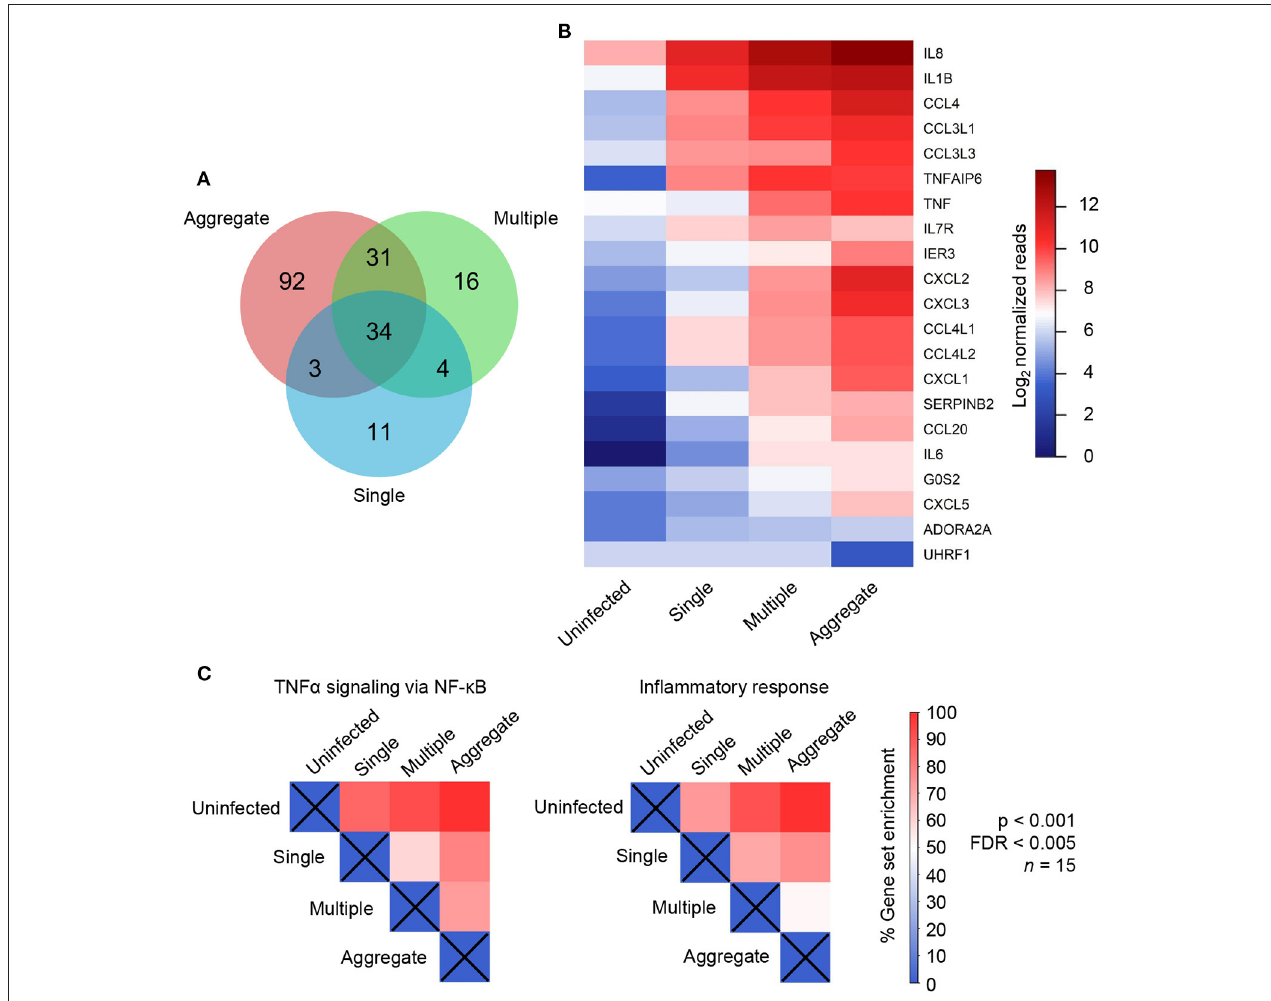
FIGURE 2 | Individual genes and gene sets were differentially regulated in aggregate Mycobacterium tuberculosis (Mtb) infection. (A) Venn diagram showing the number of differentially regulated genes in single (blue), multiple (green) and aggregate Mtb (salmon) infected macrophages relative to uninfected macrophages as identified by DESeq2 differential expression analysis. (B) Heatmap showing read counts of genes identified as most variably expressed between infection conditions and selected by DESeq2 as significant (21 genes). (C) Normalized enrichment score (NES), expressed as percentage of maximum enrichment for the gene sets defined as “TNF α signaling via NF- κ B” and “Inflammatory response.” Enrichment scores were calculated for all treatment comparisons and were significantly different at nominal p < 0.001 and FDR < 0.005, with the exception of the aggregate to multiple comparison for the “inflammatory response” gene set (where p < 0.05 and FDR =